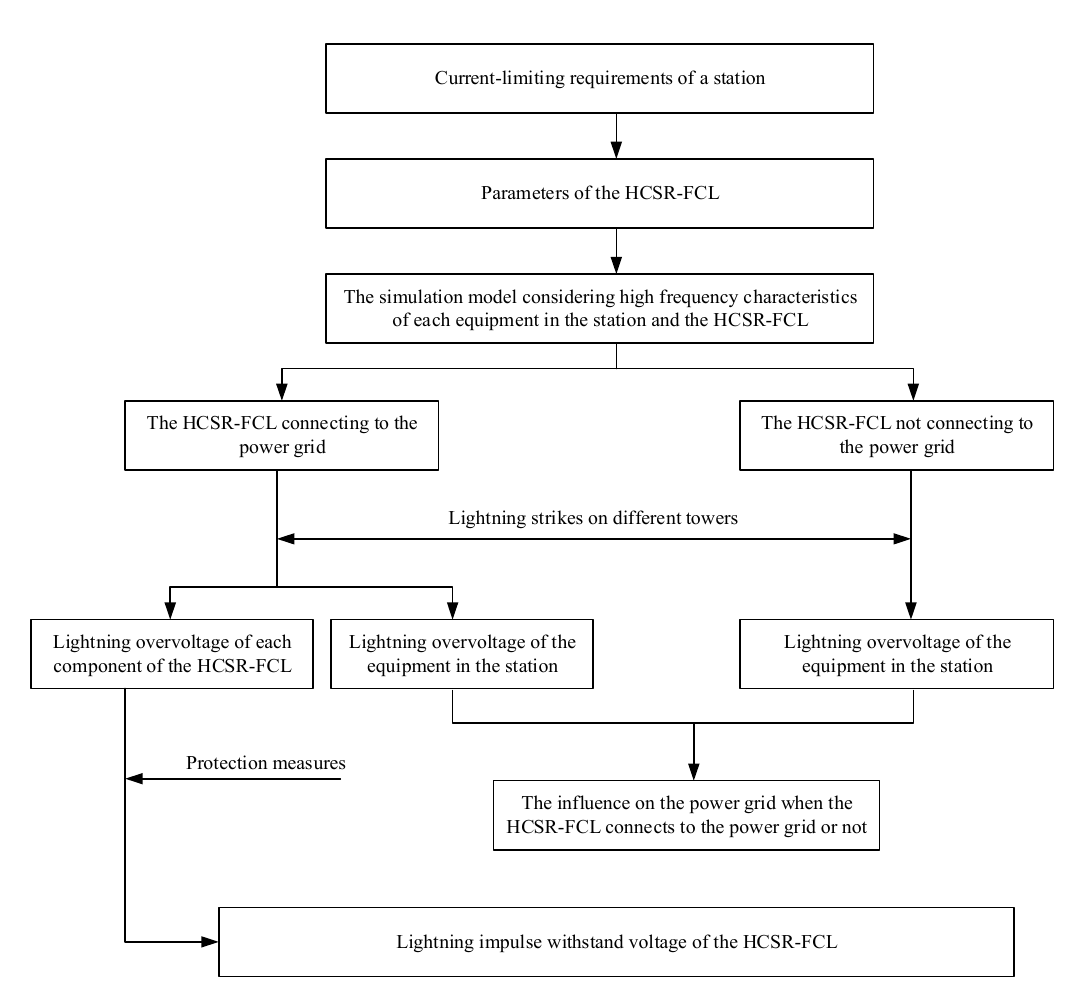
Figure A1. The flow chart of the method how to study the lightning overvoltage and insulation design of the HCSR-FCL.